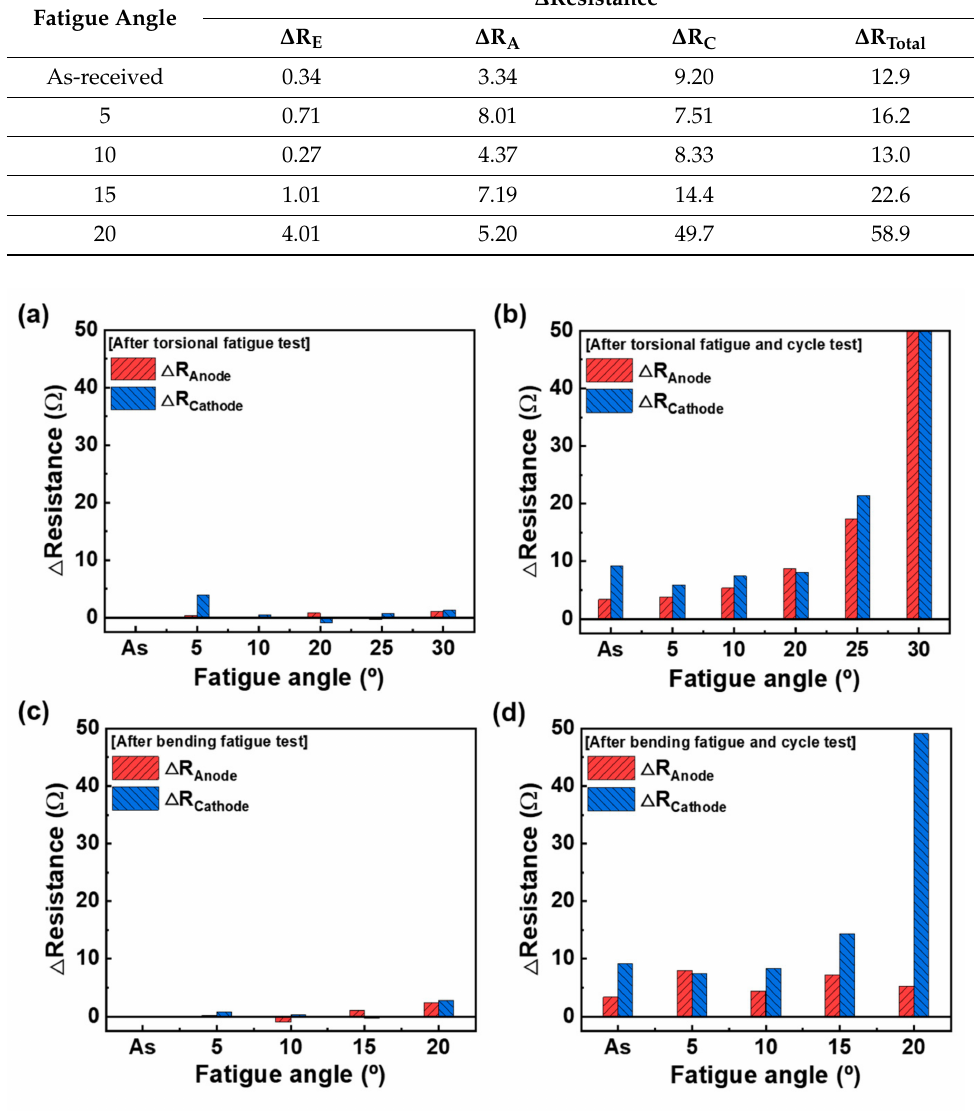
Figure 8. Anode and cathode resistance changes under different torsional and bending test degrees: ( a ) after the torsional fatigue test, ( b ) after the torsional fatigue and cycling test, ( c ) after the bending fatigue test, and ( d ) after the bending fatigue and cycling